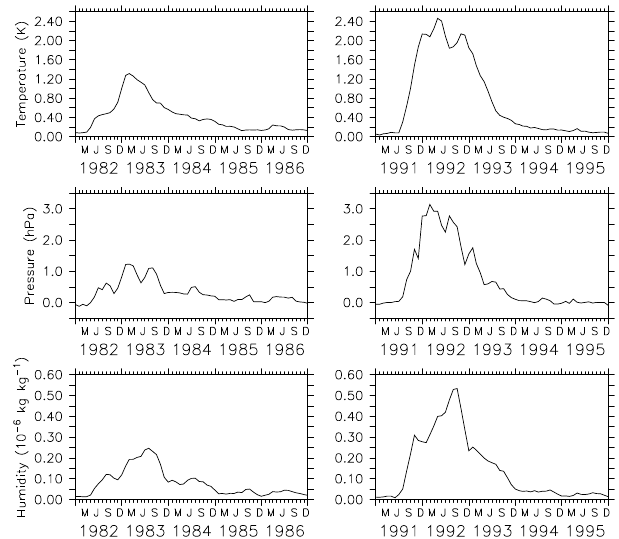
Figure 7. Zonally averaged differences (VOL-NOVOL) in temper- ature, pressure, and humidity at the cold point in the tropics (5 ◦ S– 5 ◦ N), zonally averaged for the El Chichón period (left) and the Mount Pinatubo period